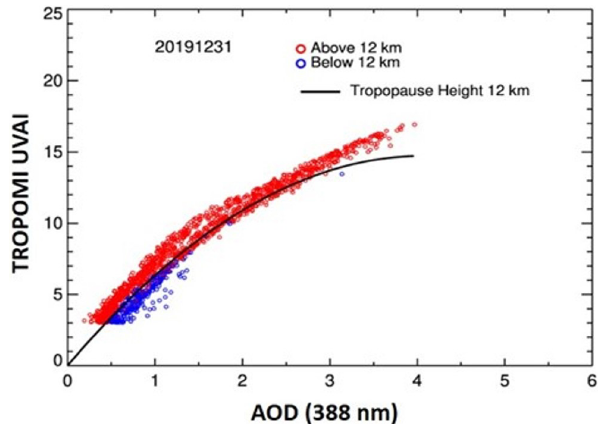
Figure 12. UVAI–AOD relationship at ALH 12km for the 2019– 2020 Australian fires (black line) on 31 December 2019. Red sym- bols represent aerosol retrievals at 12km and higher. Blue symbols indicate retrievals at heights lower than